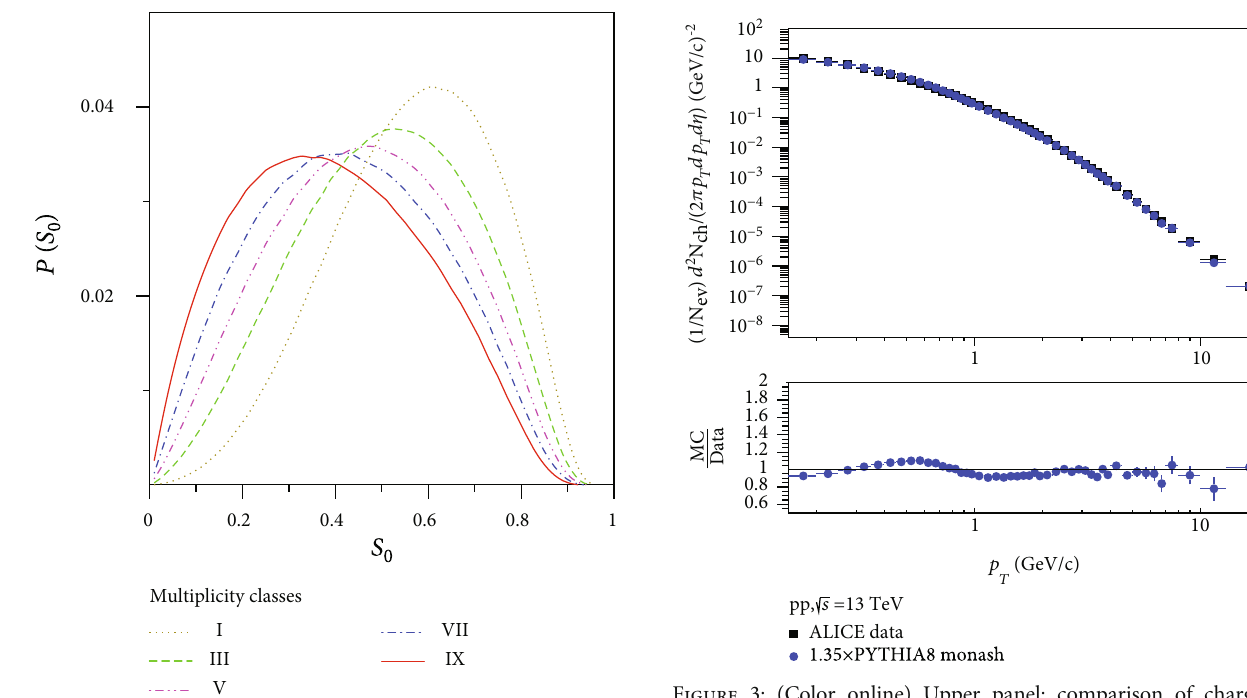
ffiffi p = 13TeV using PYTHIA8. s